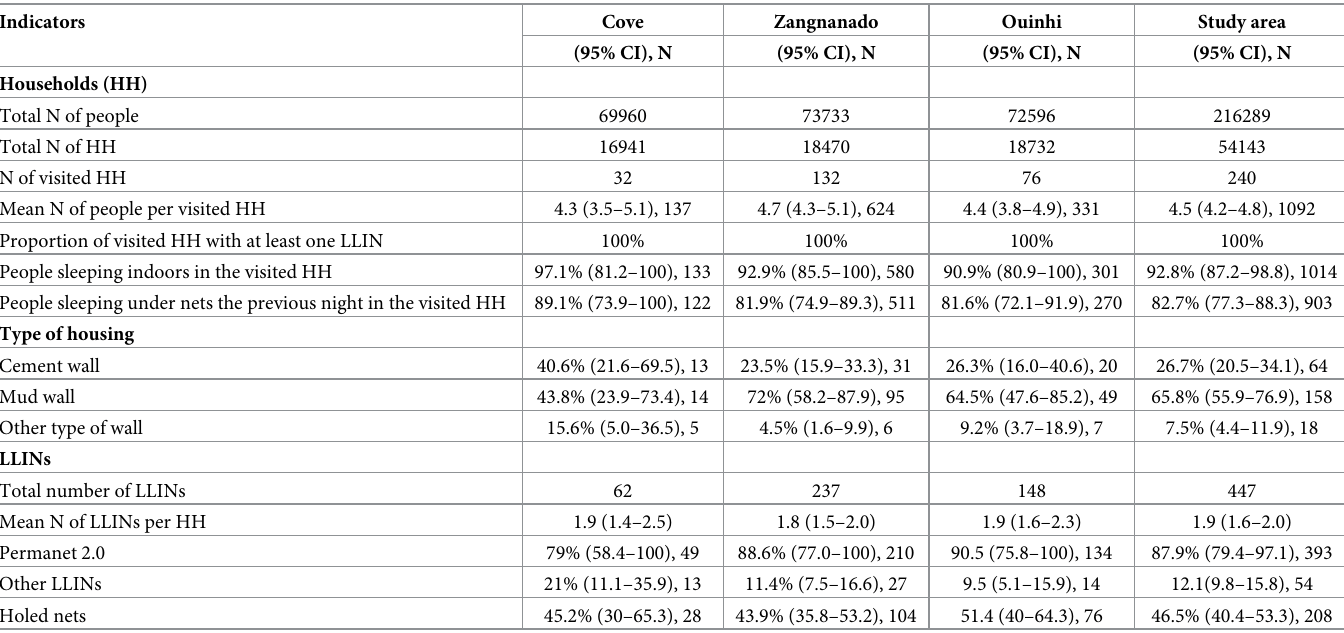
Table 2. Household and individual characteristics of study